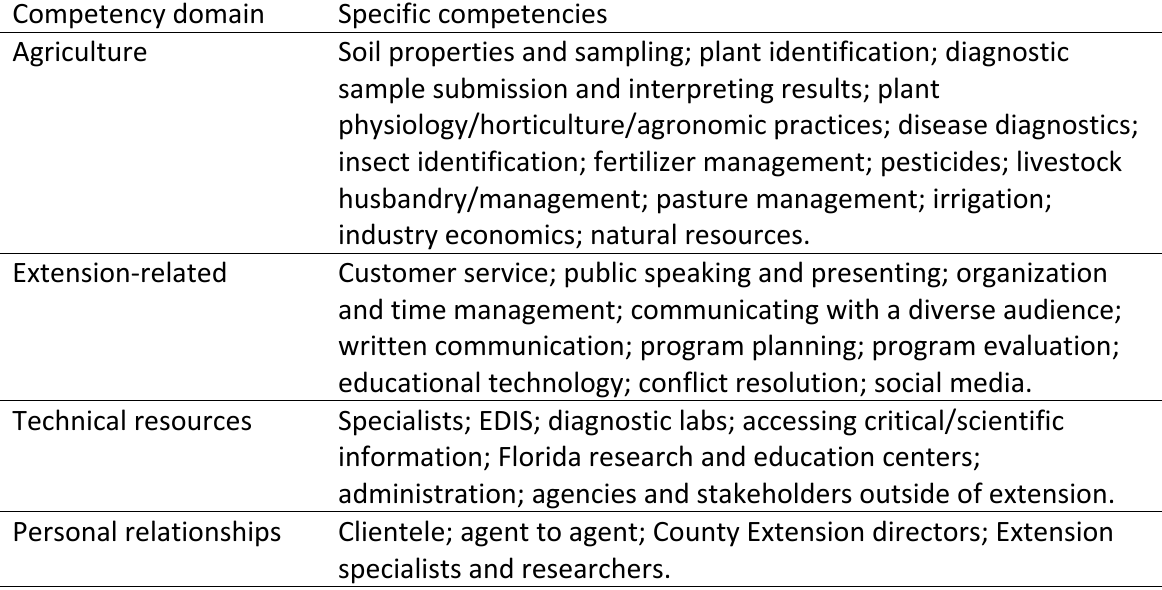
List of Competency Domains and Competencies deemed Important by Respondents Competency